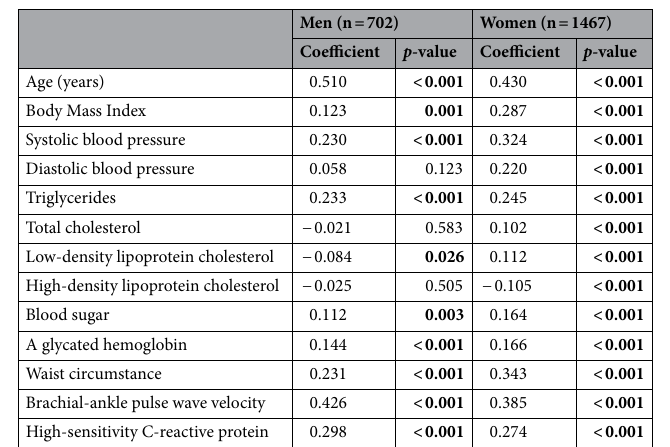
Table 3. Correlations between mid-regional pro-adrenomedullin and cardiometabolic parameters. Correlations are analyzed by Spearman’s rank correlation analysis. Bold style represents p < 0.05.